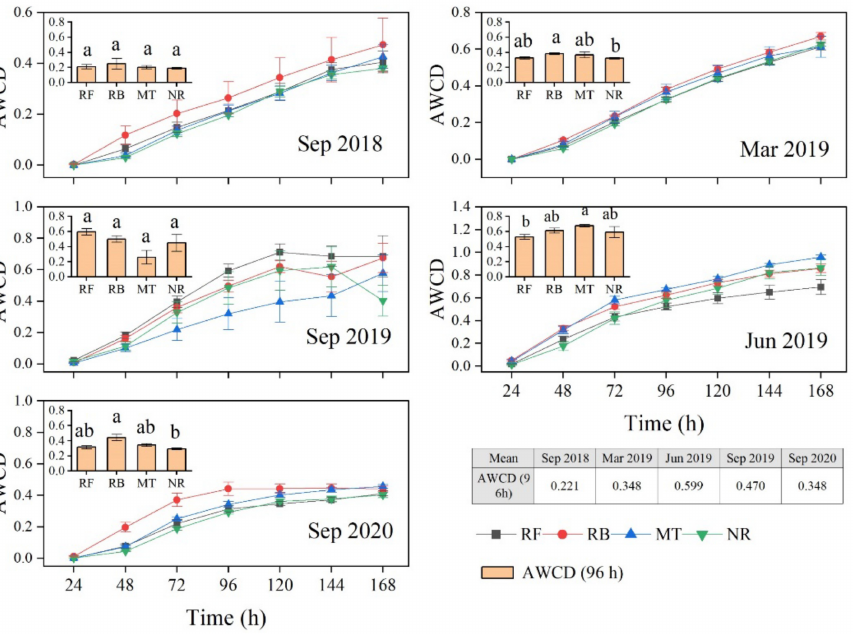
Figure 3. Effects of the use of different harvest residue management methods on average well color development (AWCD) from 2018 to 2020. Data are means ± standard errors, and different lower-case letters indicate significant differences among the residue treatments ( p <